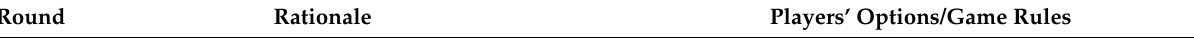
Table 2. Generic 1 game rounds, showing players’ options and rationale for each